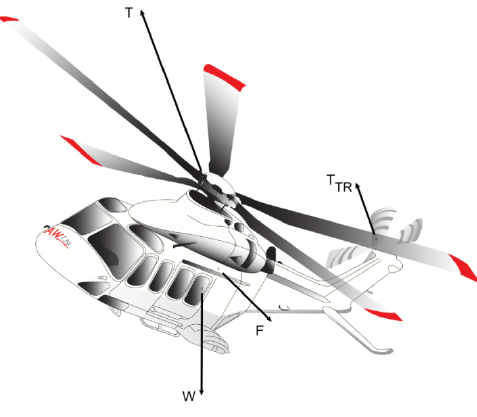
Figure 29: Balance of forces acting on the